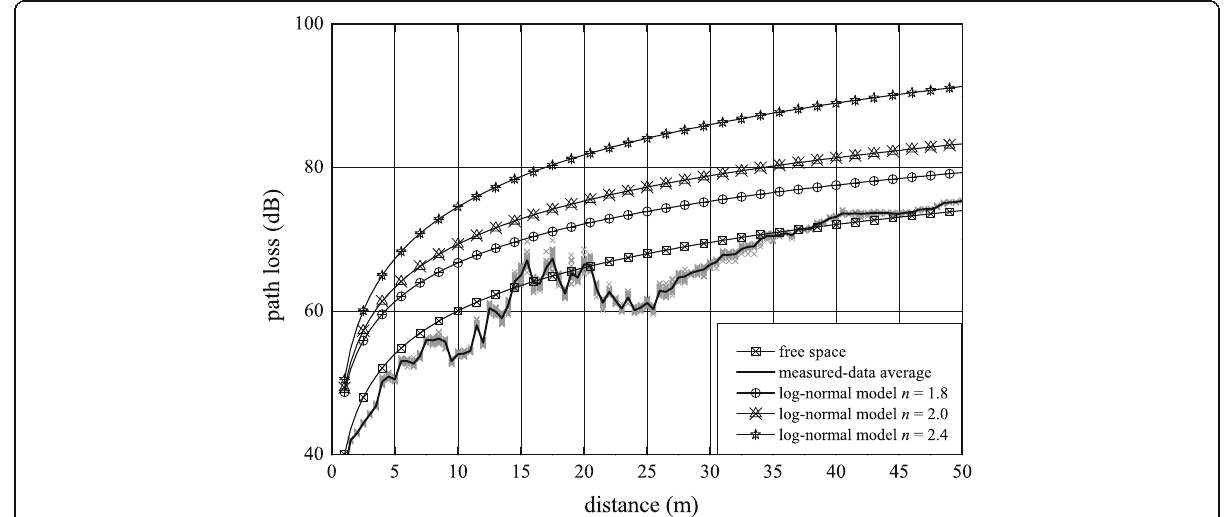
Fig. 5 Path loss obtained from measurement and prediction of the second case with 1-m antenna height above the ground